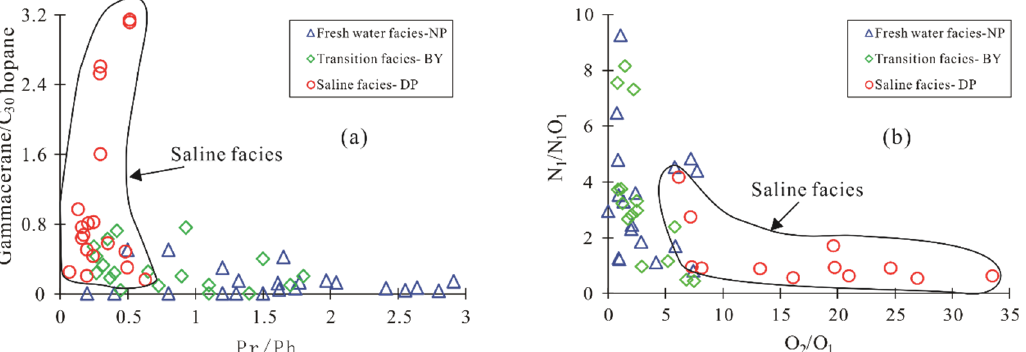
Figure 13. Parameters from ( a ) conventional GC-MS and ( b ) high resolution mass spectrometry to identify different sedimentary environments.